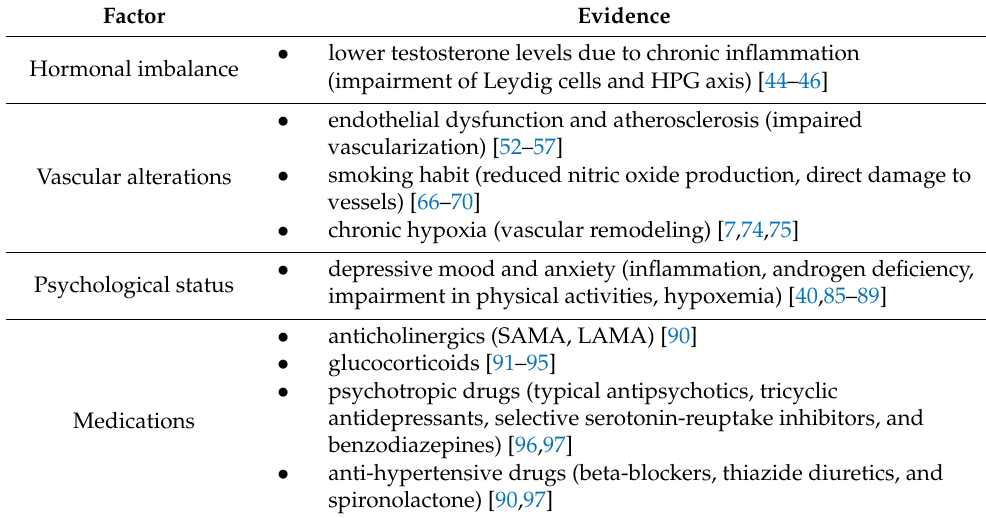
Table A1. Presumed Causes of ED in COPD